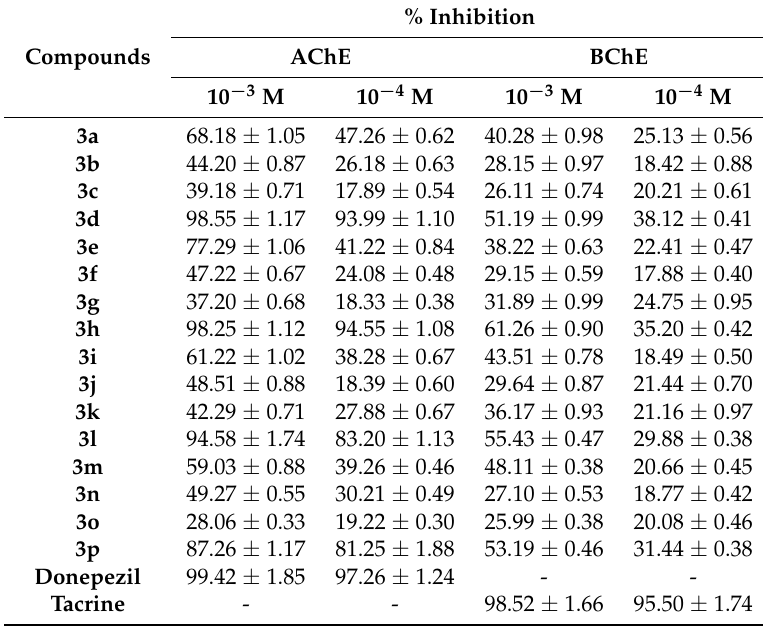
Table 1. % Inhibition of all compounds 5a – p against AChE and BChE enzymes.